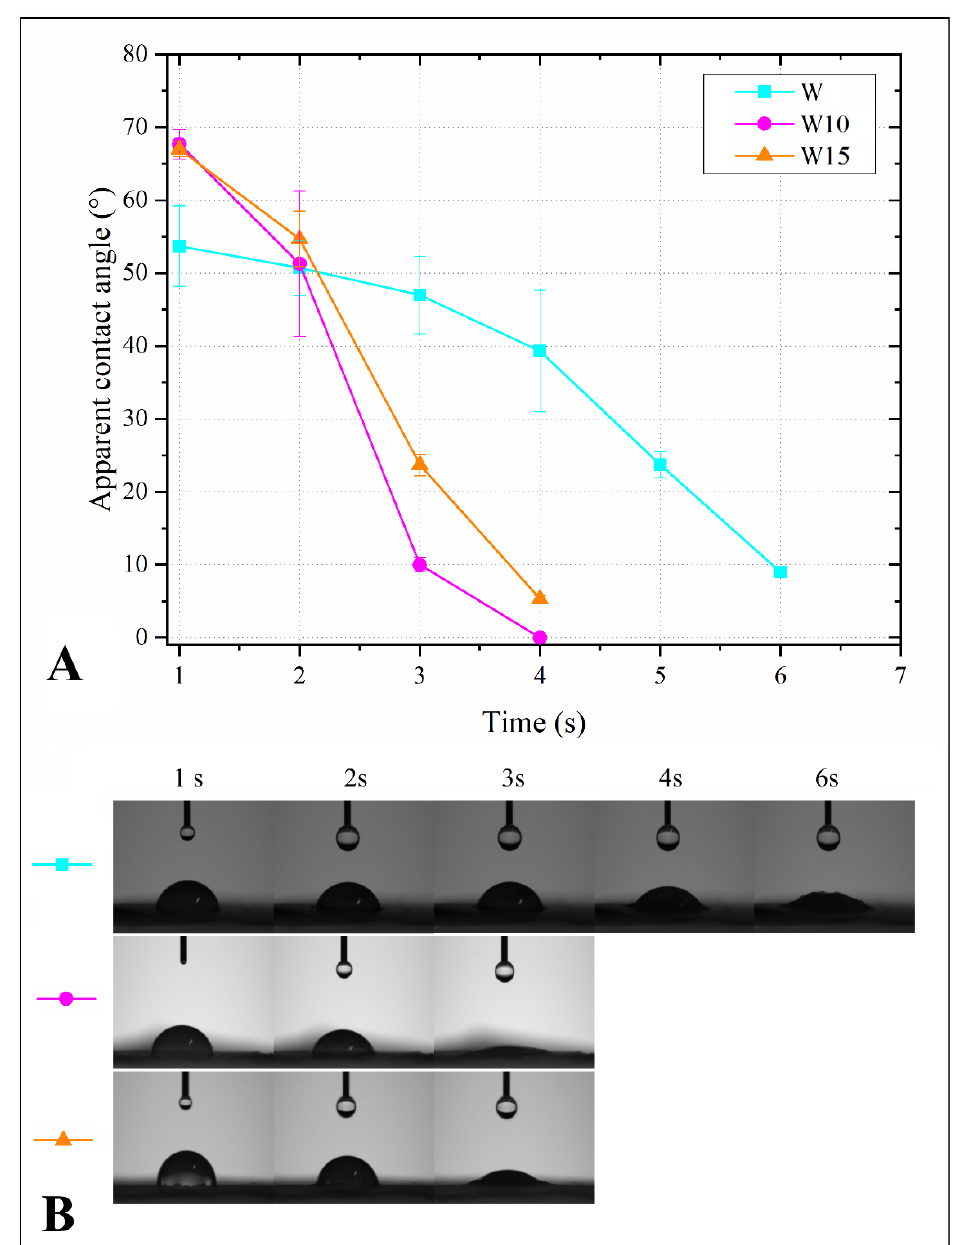
Figure 2. Apparent contact angle evolution in terms of mean values ( A ) and images ( B ) for the studied fillers.